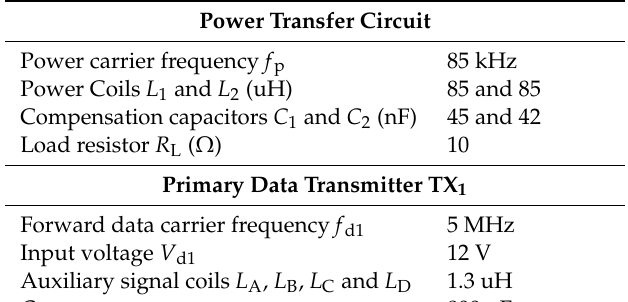
Figure 12. Experimental setup of proposed magnetic positioning method. Table 3. System parameters.